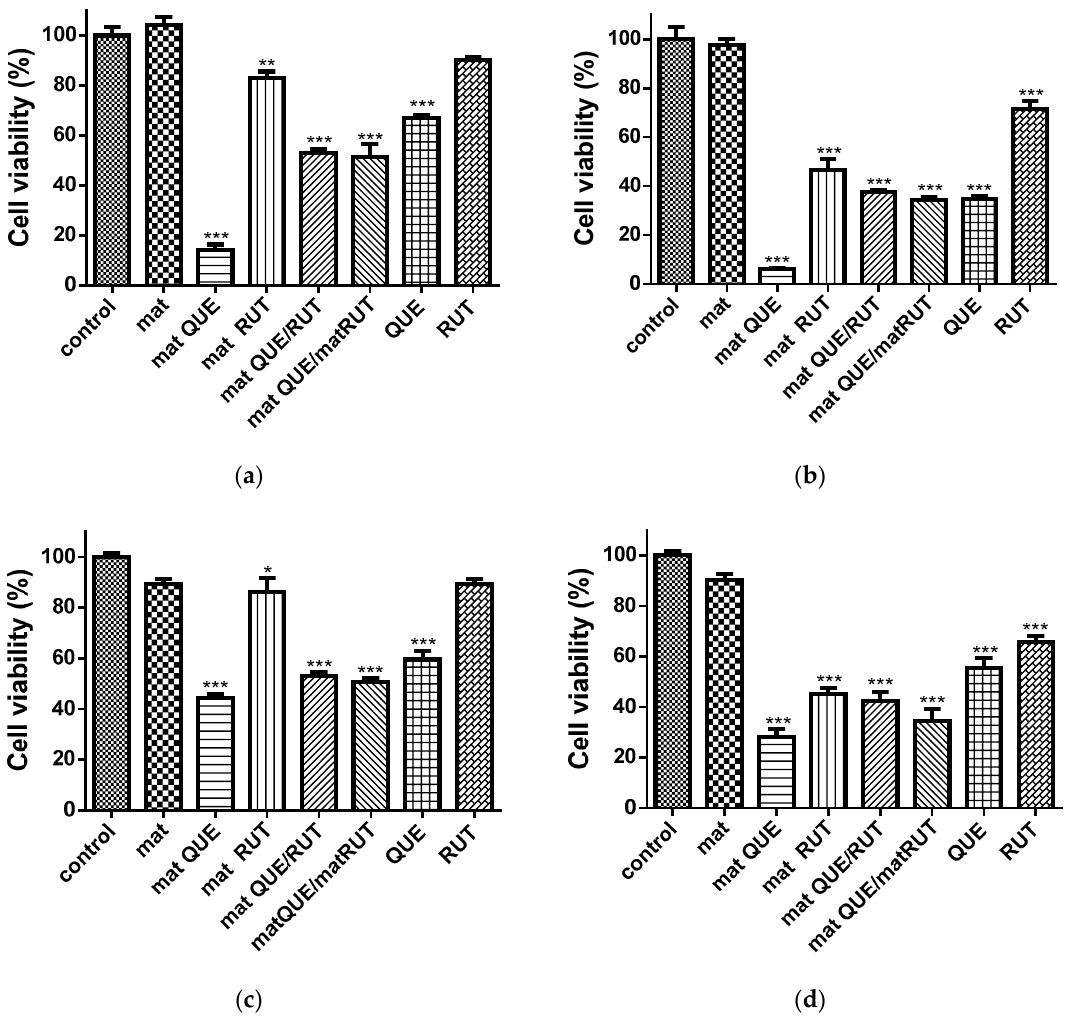
Figure 8. Effect of mats on HeLa tumor cells ( a , b ) and mouse BALB/c 3T3 fibroblast cells ( c , d ) after 24 h ( a , c ) and 48 h ( b , d ) of incubation with different formulations: control—untreated HeLa cells or mouse BALB/c 3T3 fibroblast cells, CA/PEG mat, CA/PEG/QUE mat, CA/PEG/RUT mat, CA/PEG/QUE/RUT mat, CA/PEG/QUE+CA/PEG/RUT mat, QUE (50 μ M/L), RUT (50 μ M/L), * p < 0.05, ** p < 0.01. and *** p < 0.001.